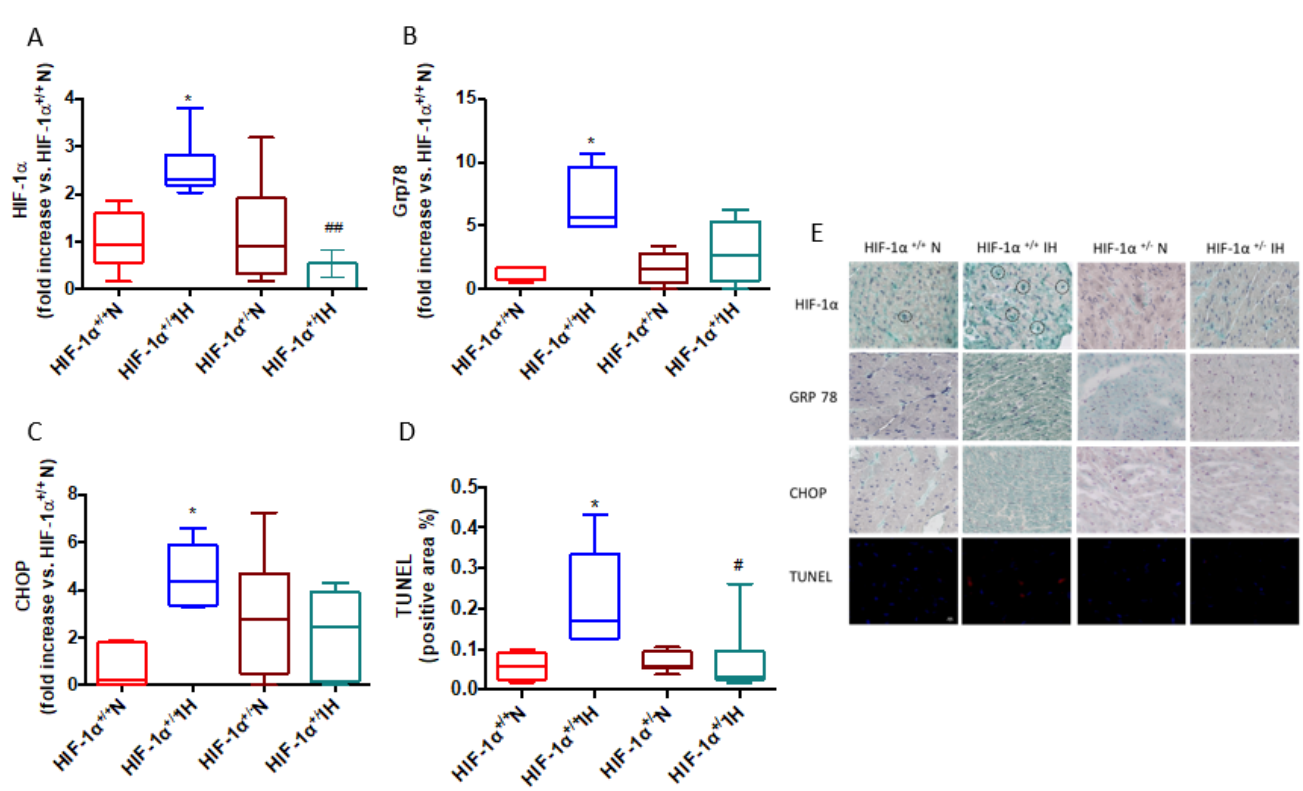
Figure 3. IH-induced ER stress and apoptosis is mediated by HIF-1. Hypoxia inducible factor-1 α ( HIF-1 α , A ), glucose regulated proteine-78 KDalton ( Grp78 , B ), C/EBP homologous protein expression ( CHOP , C ), and terminal deoxynucleotidyl transferase dUTP nick end labeling (TUNEL) counterstained with DAPI ( D ), in HIF-1 α +/+ and HIF-1 α +/ − mice submitted to normoxia (N) or chronic intermittent hypoxia (IH), n = 4–6. Representative images ( × 20) for HIF-1 α , Grp78, CHOP and TUNEL immunostainings in all groups ( E ). Data are expressed in median and min to max values and analyzed using Kruskal–Wallis followed by Dunn’s test; * p < 0.05 vs. IH; # p < 0.05 and ## p < 0.01 vs. HIF-1 α +/+ .